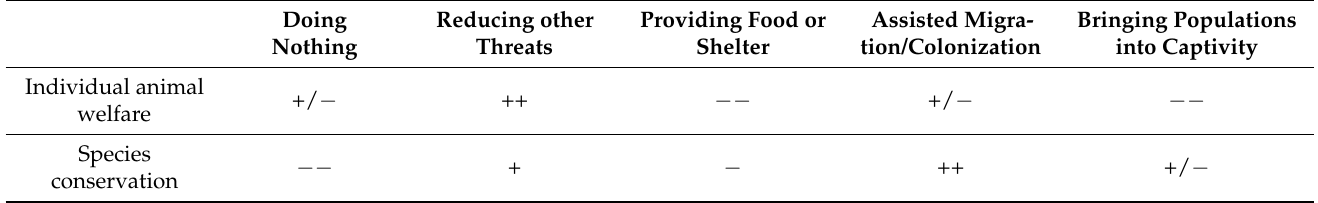
Table 1. Overview of the measures and the likely effects on individual animal welfare and species